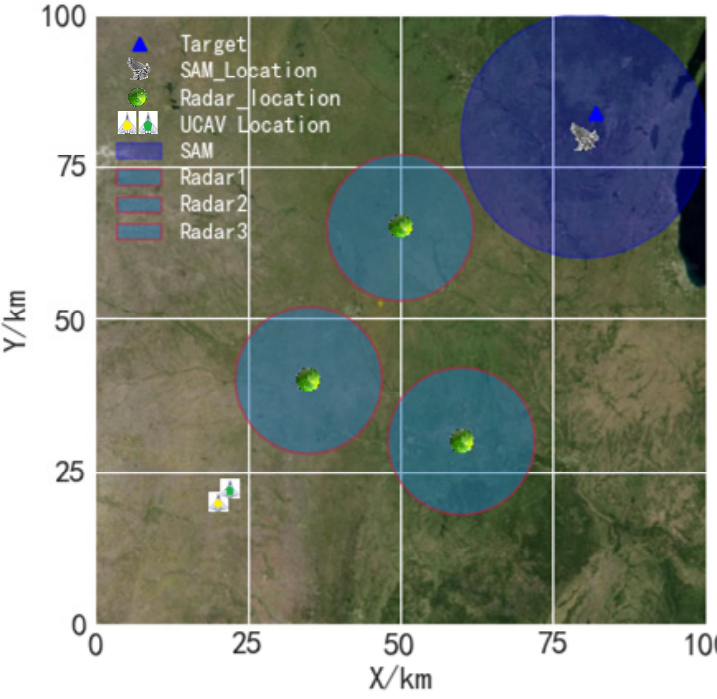
Figure 1. Schematic of a dual-UAV cooperative reconnaissance mission.